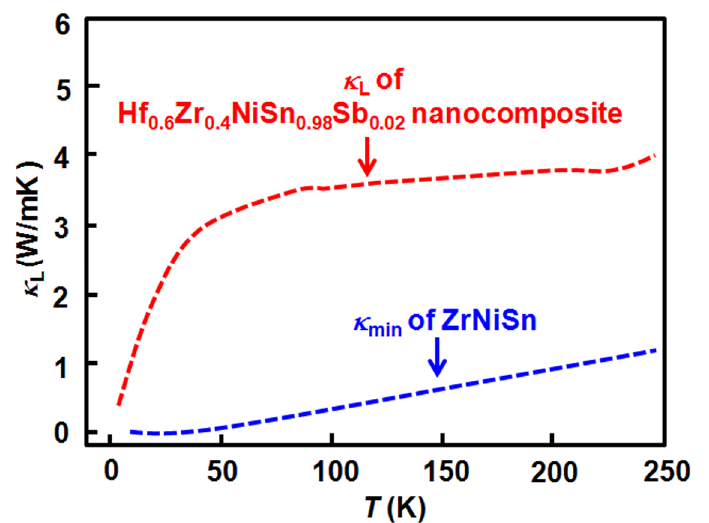
Hf NiSn Sb 0.4 0.6 0.98